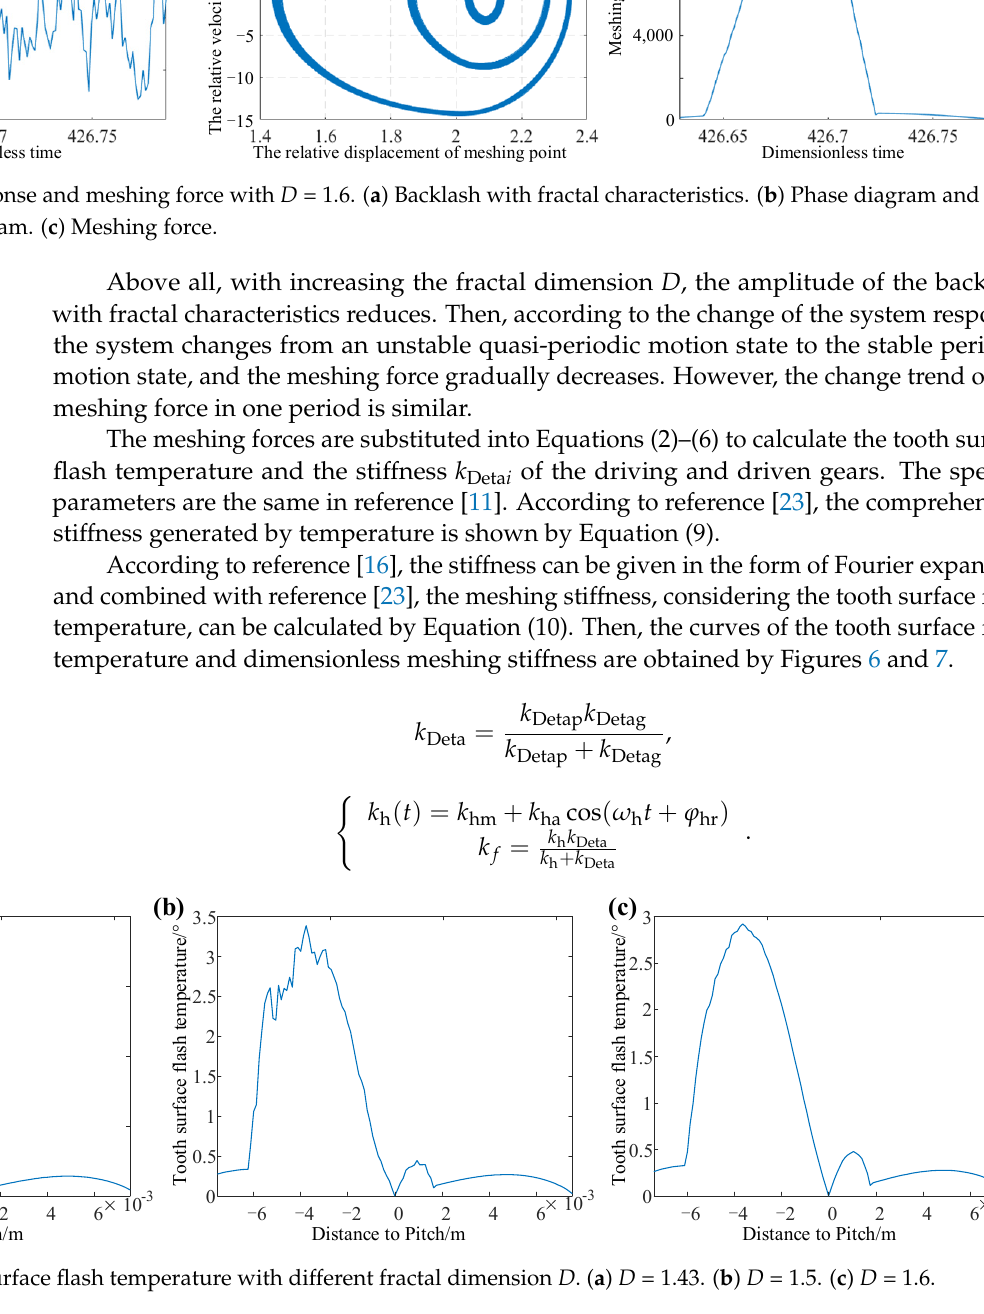
Figure 4. System response and meshing force with D = 1.5. ( a ) Backlash with fractal characteristics. ( b ) Phase diagram and Poincare section diagram. ( c ) Meshing force.